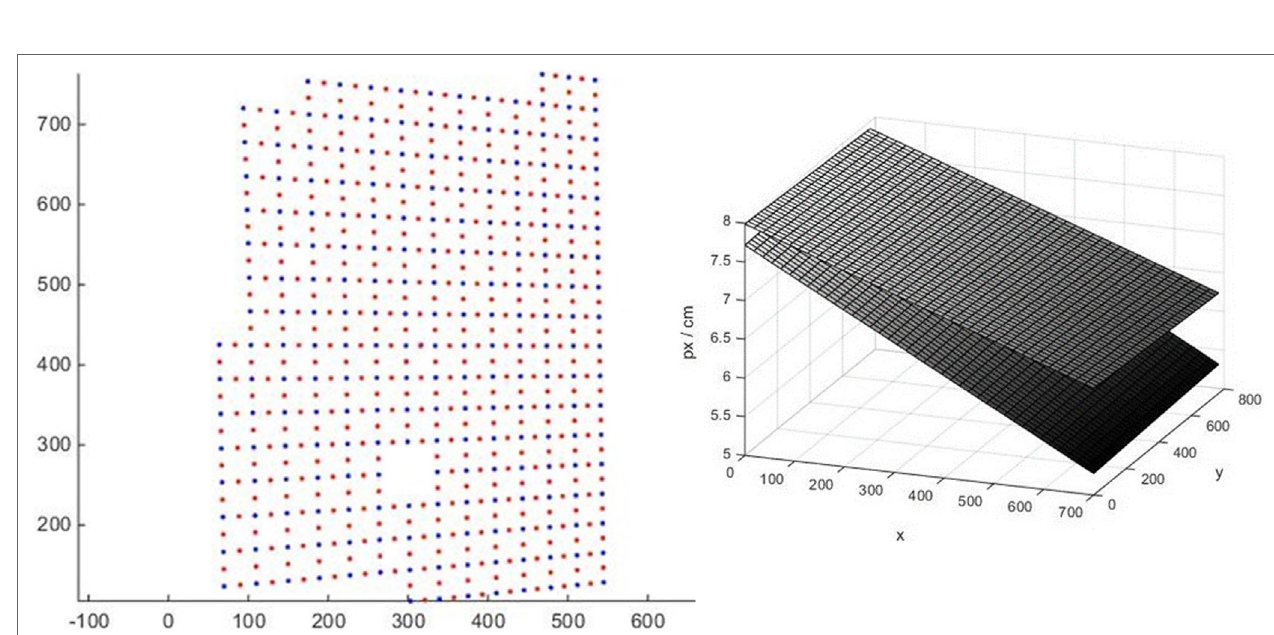
FIgURe 5 | Left: blue dots show the calibration target markers corrected for lens distortion, thus all dots form straight lines. Red dots are locations of spacing realizations half way between markers. Right: pixel size maps, where upper plane is pixel size in the y direction, lower is in the x